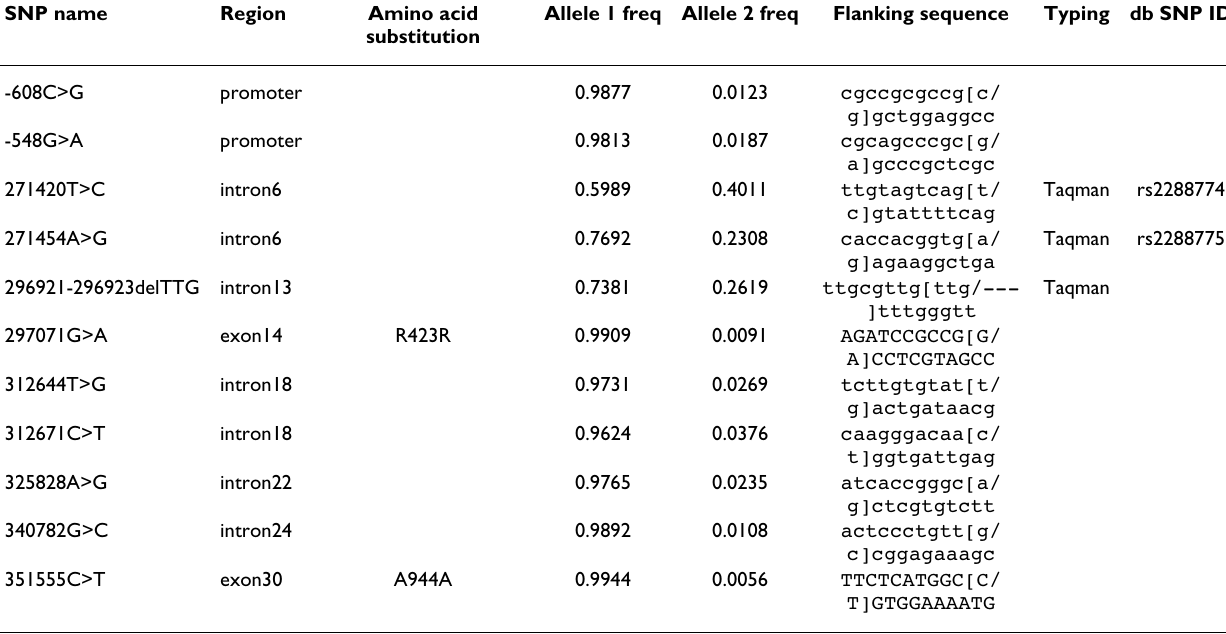
Table 1: Sequence variations in the promoter region and exons in Nedd4L identified in Kazakh hypertensive